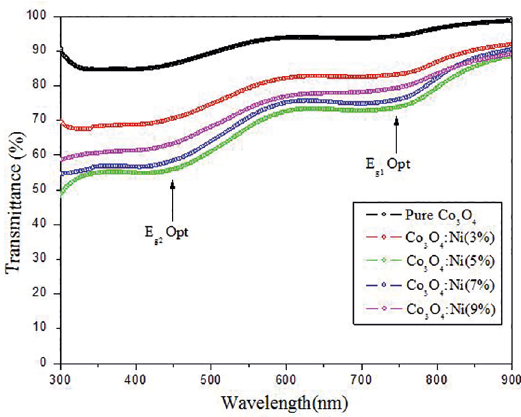
Figure 2. Transmittance spectra of pure and Ni-doped Co